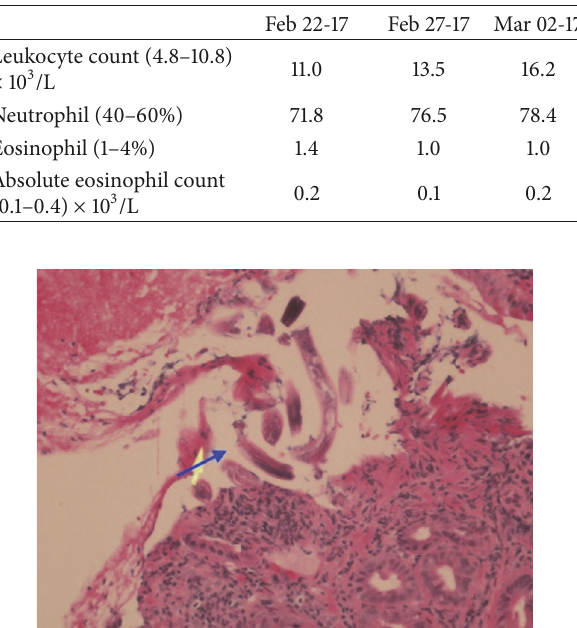
Table 1: Patient’s laboratory examination results (hematology).